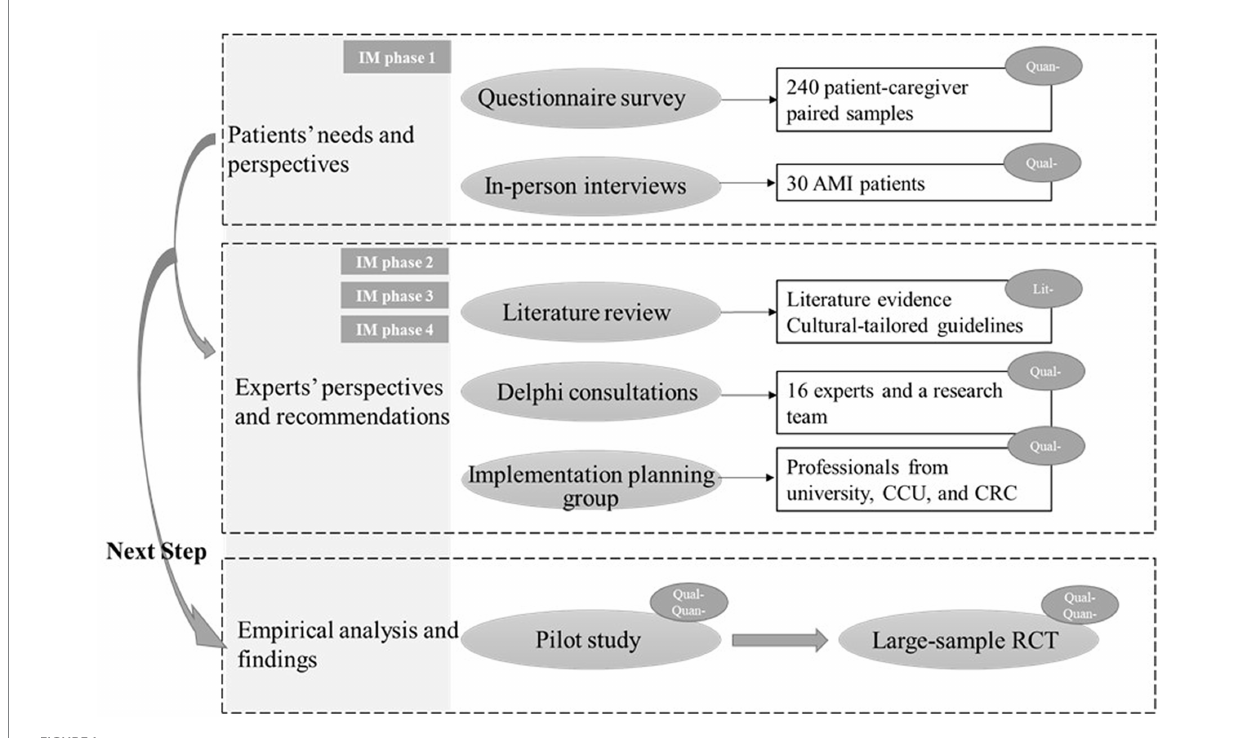
FIGURE 1 Flow diagram of the research process based on the IM